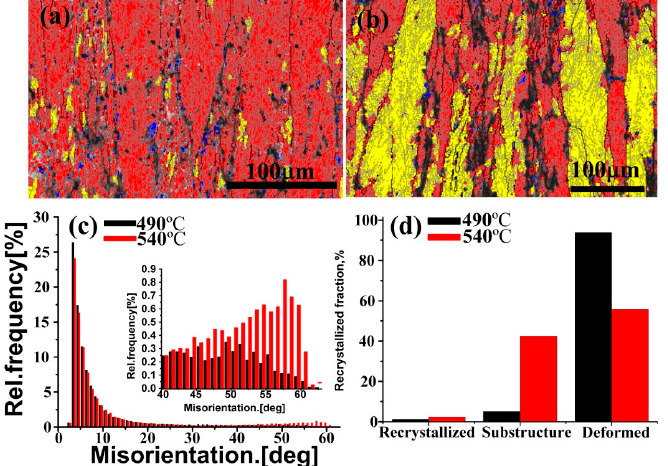
Figure 6. Electron backscatter diffraction (EBSD) map of RQ samples preheated at ( a ) 490 °C; ( b ) 540 °C (recrystallization in blue; substructure in yellow; retained deformation structure in red); ( c ) grain boundary misorientation distribution; ( d ) corresponding area fractions of recrystallized, deformed structure and substructure according to internal